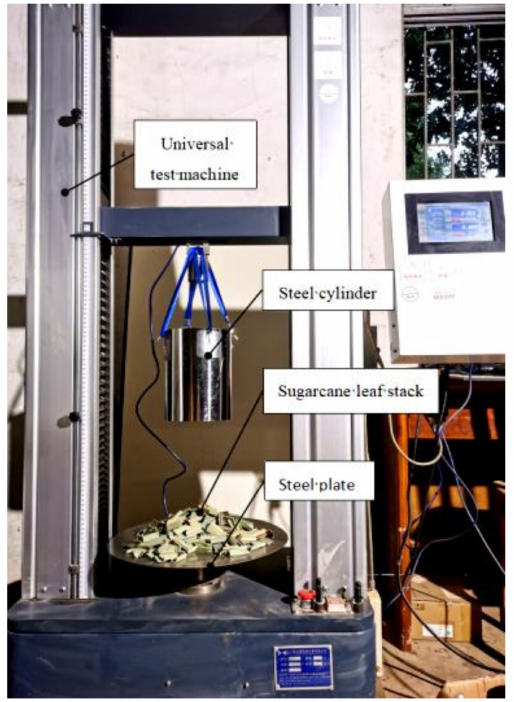
Figure 1. Test of the physical angle of repose in sugarcane leaves.